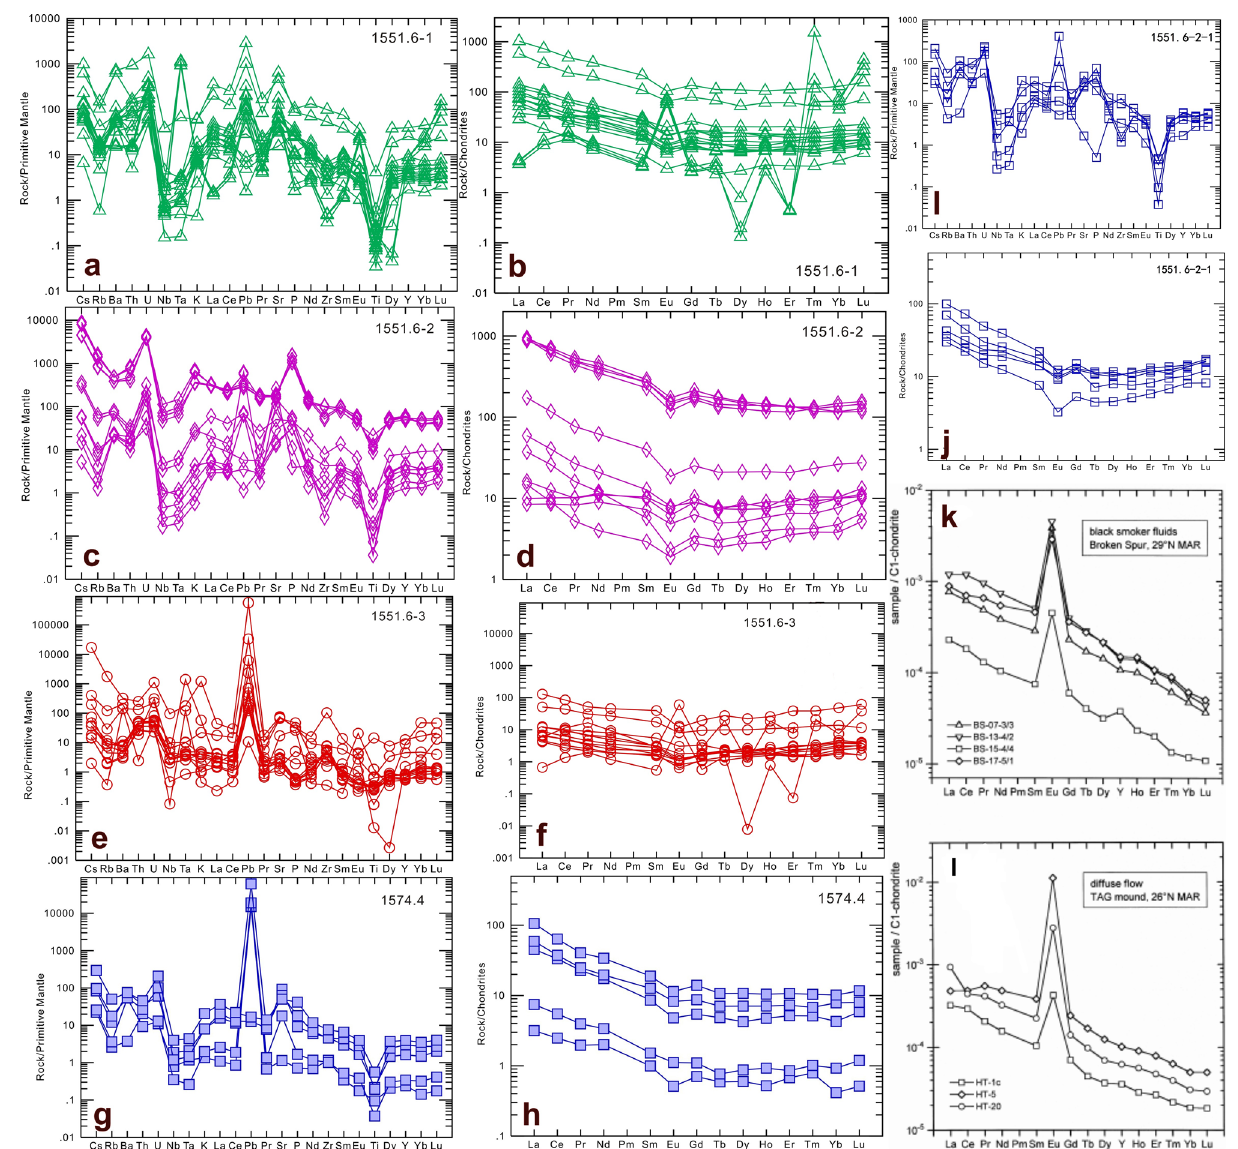
Figure 6. Standardized spider diagrams of REEs/chondrites and trace elements/primitive mantle from the hydrothermal chimney (Note: The data of panels ( a , b ) are from blue line No. 1 in Fig. 5, hydrothermal dolomite; the data of panels ( c , d ) are from blue line No. 2 in Fig. 5, Mixture of hydrothermal sedimentary rock and mudstone; and the data of panels ( e , f ) are from blue line No. 3 in Fig. 5, hydrothermal pyrite. The data for panels ( g , h ) are from sample 1574.4, hydrothermal dolomite. The data for panels ( i , j ) are from sample 1551.6-2, hydrothermal dolomite). REYCN patterns of ( k ) high-temperature hydrothermal fluids from the Broken Spur vent site, 29° N Mid-Atlantic Ridge, and ( l ) low-temperature diffuse hydrothermal flow at the TAG hydrothermal mound, 26° N Mid-Atlantic Ridge 27 eastern Pacific Ocean hydrothermal sedimentation area. Some projection points of the 1574.4 sample plot in the hydrothermal deposition area, and some projection points plot in the hydrothermal deposition area of the Red Sea; some projection points of the 1551.6–2 sample plot in the hydrothermal deposition area of the Red Sea, and other projection points plot close to the hydrothermal-rich deposition zone. Formation and growth of hydrothermal chimneys. In the Chang 7 depositional period of the Triassic Yanchang Formation, the Ordos Basin had the characteristics of frequent event sedimentation, strong tectonic activity and activation of basement faults, which created favorable conditions for hydrothermal jet activity 17 . According to the petrological and mineralogical characteristics of hydrothermal chimneys in the study area, we established a hydrothermal chimney formation model for the area (Fig. 2a). It is believed that the sulfate formation stage and the sulfide and carbonate formation stage are the main stages experienced by the hydrothermal chimney in the study area. ① The chimney walls are initially constructed